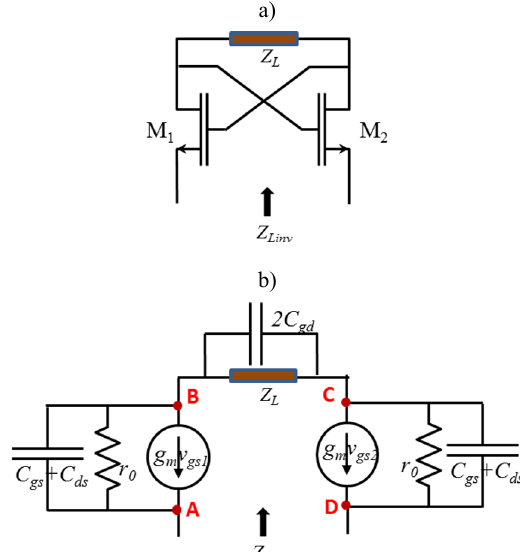
Fig. 7. a) Linvill circuit with MOSFET transistors. b) Small- signal model of the Linvill